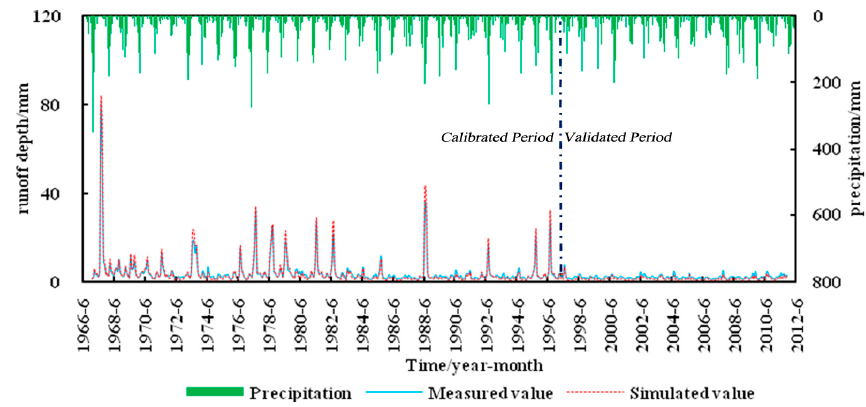
Figure 6. Observed and simulated annual streamflows at Shangjingyou Station.